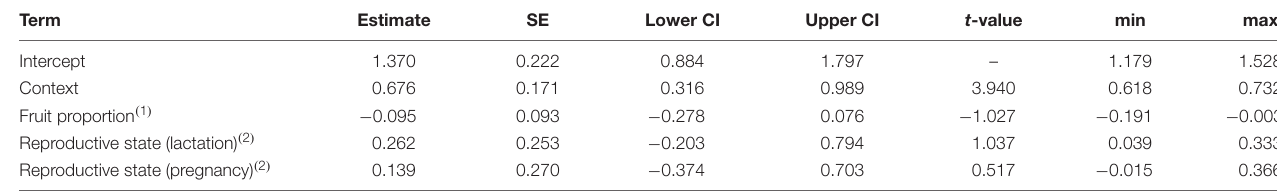
TABLE 3 | Results of the model of the effects of song context, female reproductive state, and fruit proportion in the diet, on the duration of singing bouts: estimates, together with standard errors, confidence intervals, test results, and minimum and maximum of model estimates derived by dropping levels of random effects one at a time.